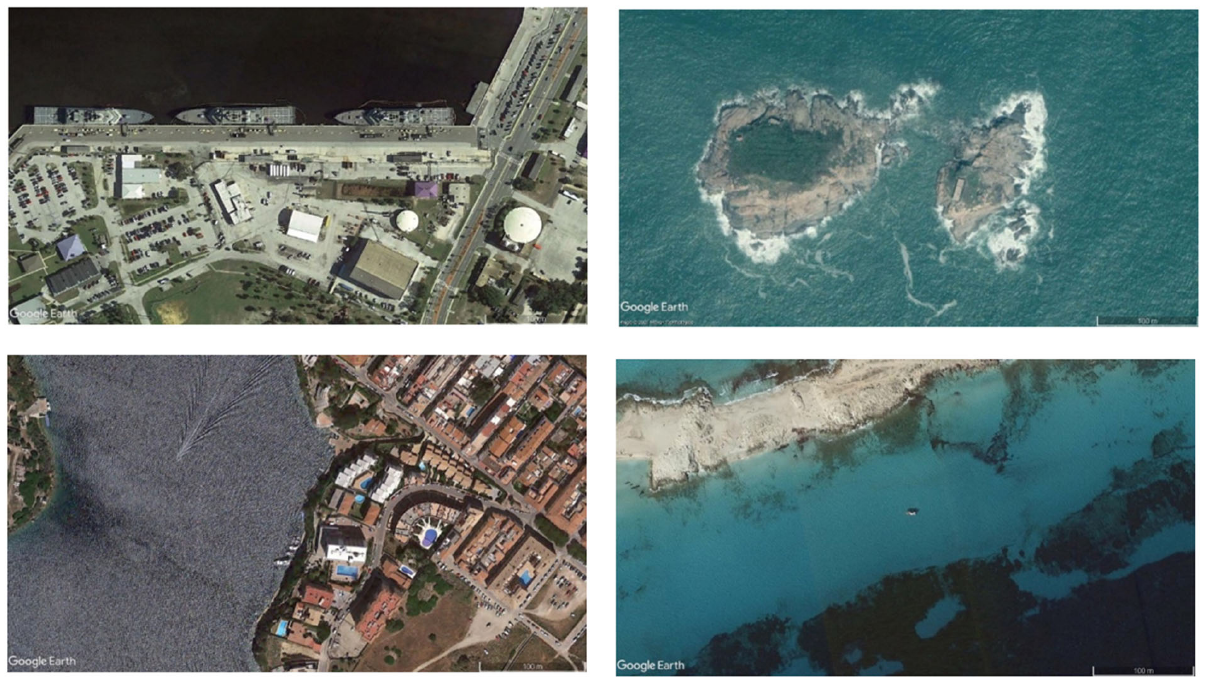
Figure A6. The example images from VHRShips with urban (left column) and rural (right column) background.